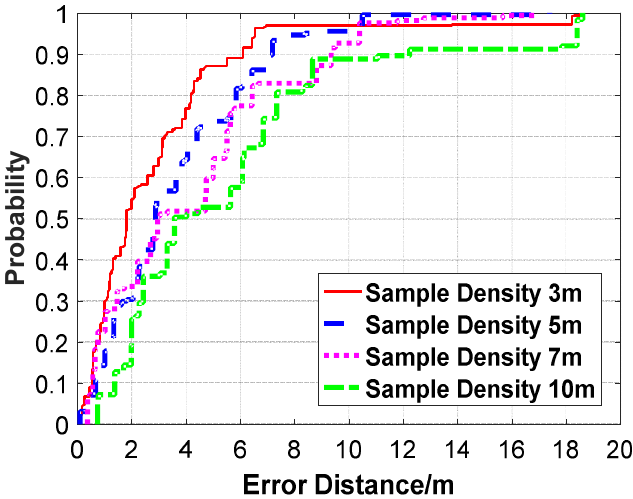
Figure 19. The CDF positioning error of our proposed algorithm under different sample densities. Table 2. Average positioning error of our proposed algorithm under different sample densities.